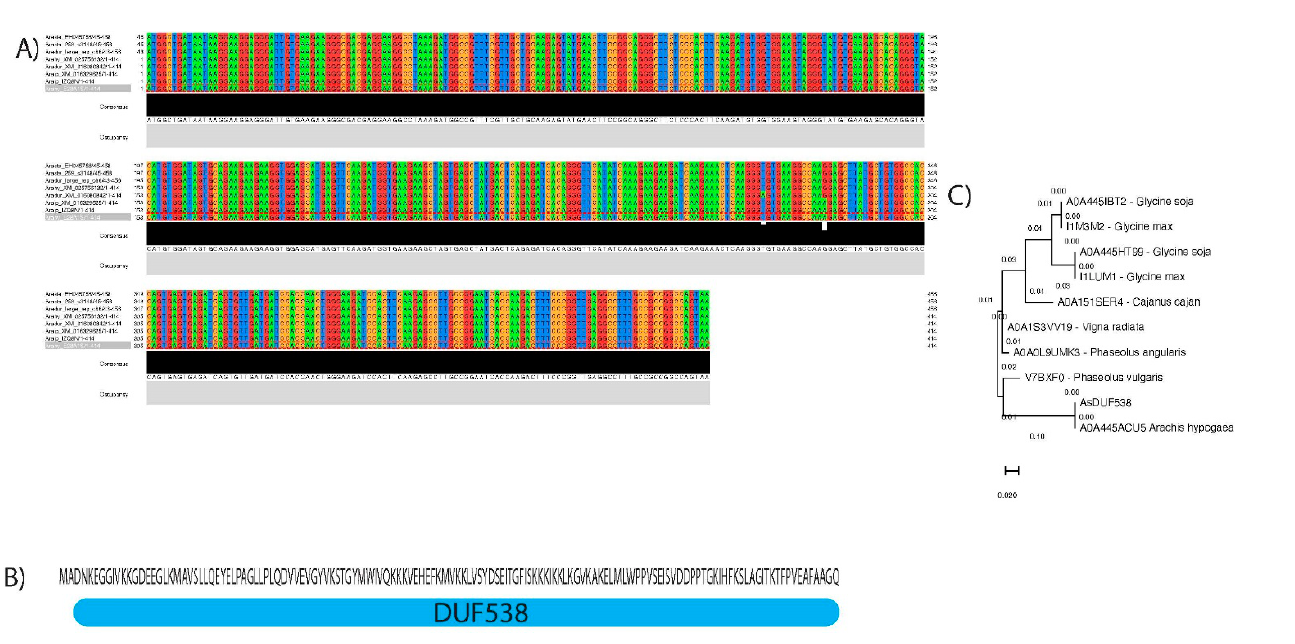
Figure 1. Molecular characterization of AsDUF538 . ( A ) Alignment of the Arachis spp. coding sequences of DUF538 and their consensus nucleotide sequence. ( B ) Deduced amino acids sequence and the location of DUF538 conserved domain. ( C ) Maximum likelihood phylogenetic tree.